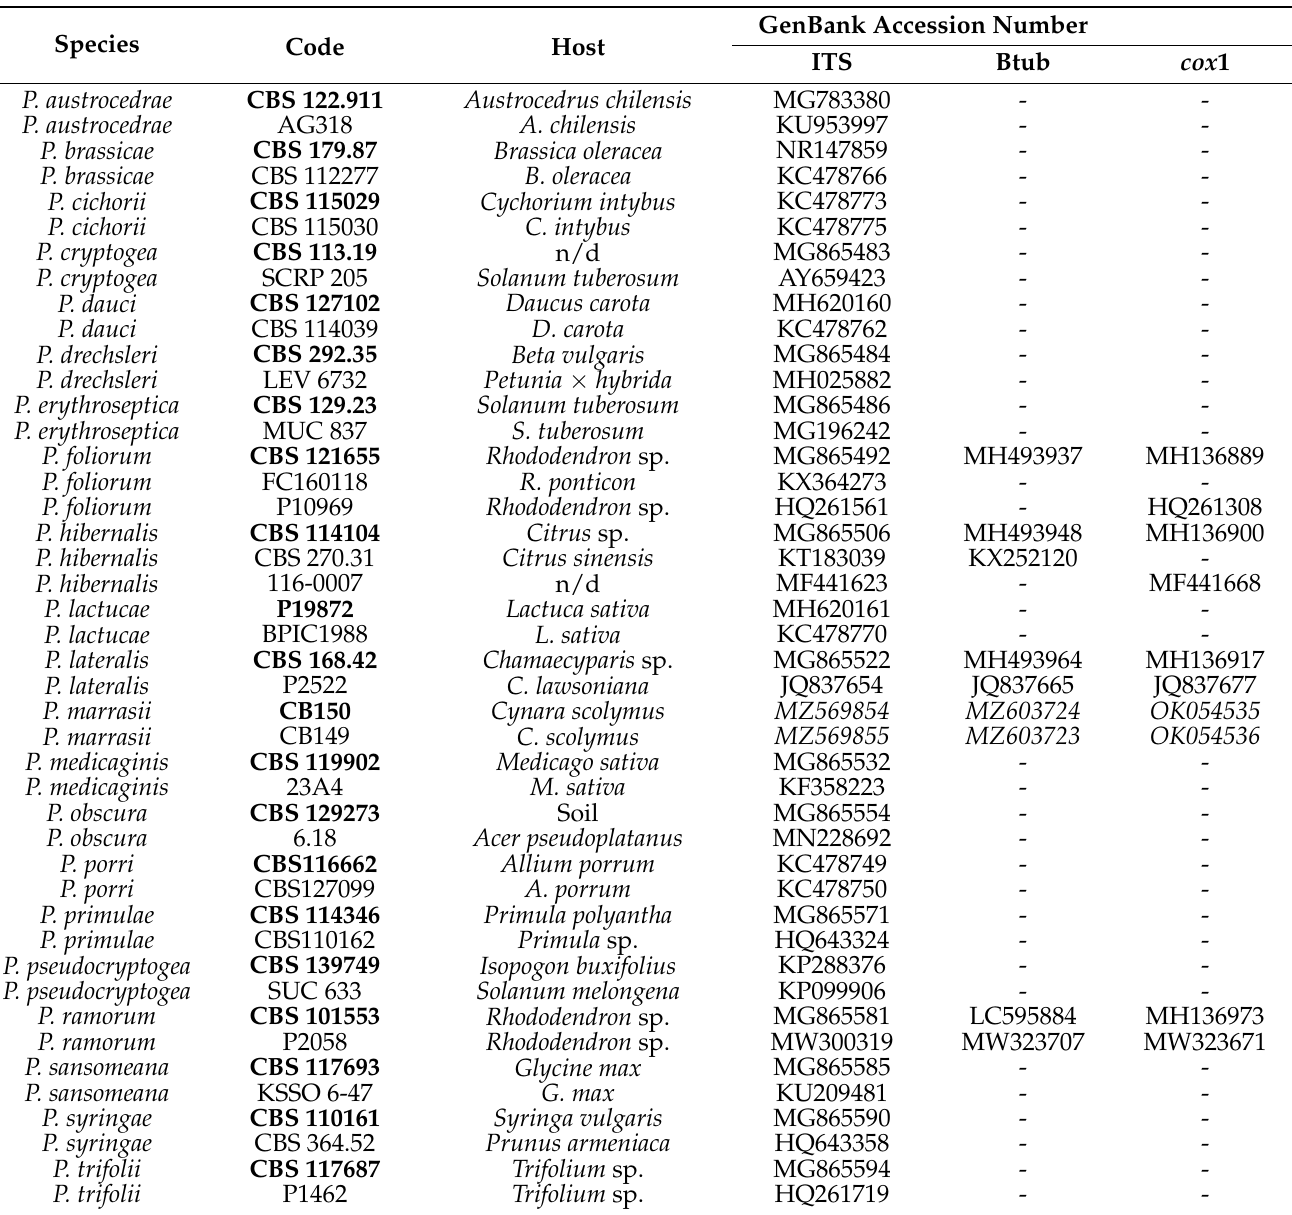
Table 2. Phytophthora isolates belonging to clade 8 included in the Maximum Likelihood (ML) analyses. Ex-type cultures are given in bold typeface, and sequences obtained in this study are indicated in